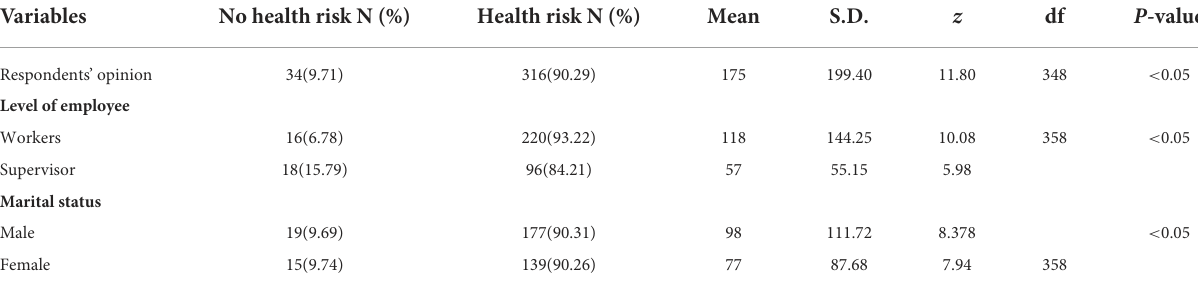
TABLE 10 Mean difference of health risk according personal factors of respondents based on Siegrist Scale ( N = 350).